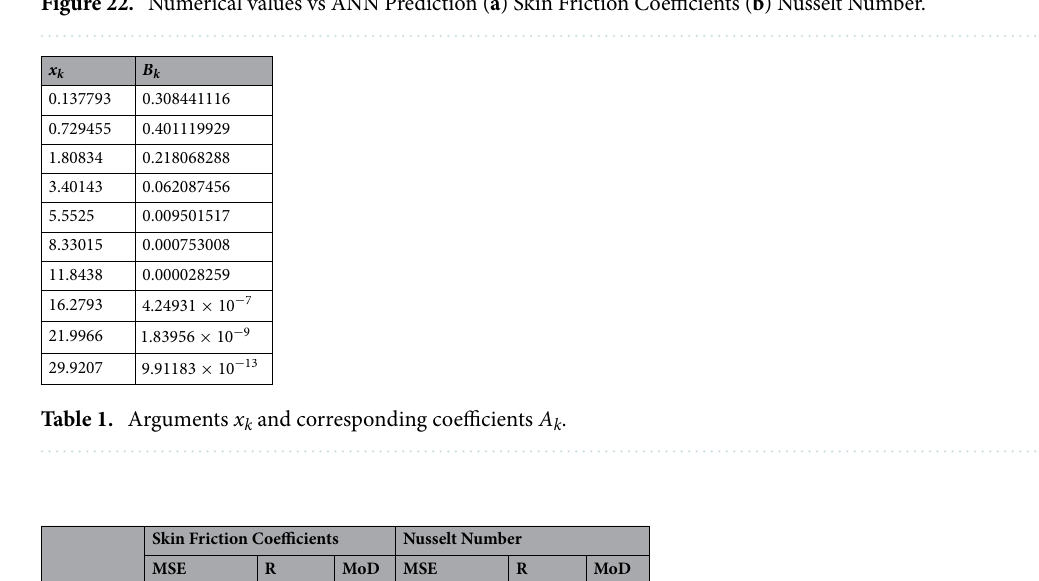
Figure 22. Numerical values vs ANN Prediction ( a ) Skin Friction Coefficients ( b ) Nusselt Number.